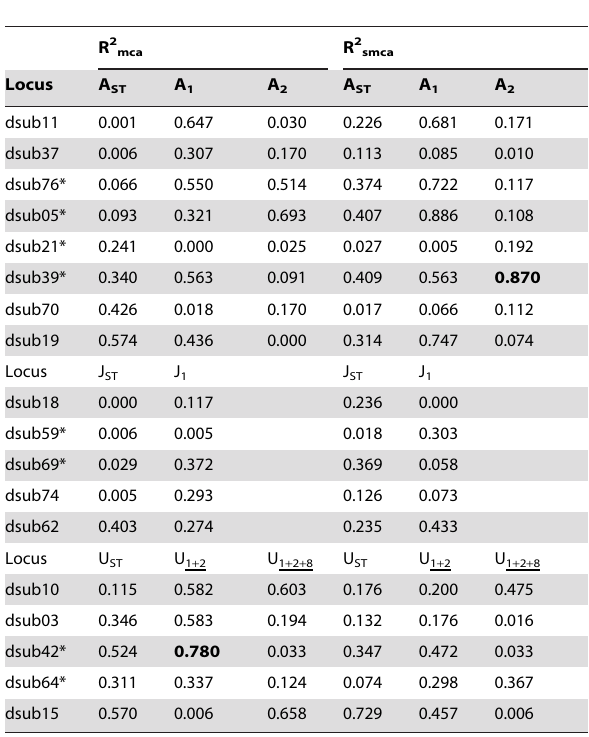
Table 3. Regression coefficients of the frequencies of the most common allele (R 2 mca ) and second most common allele (R 2 smca ) with latitude in individuals carrying the same chromosome